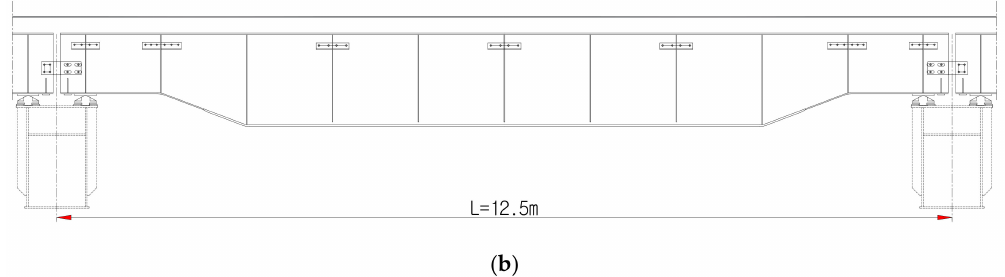
Figure 2. Yeongjong Bridge direct fixation track structure cross section. ( a ) Front view; ( b ) Side View.